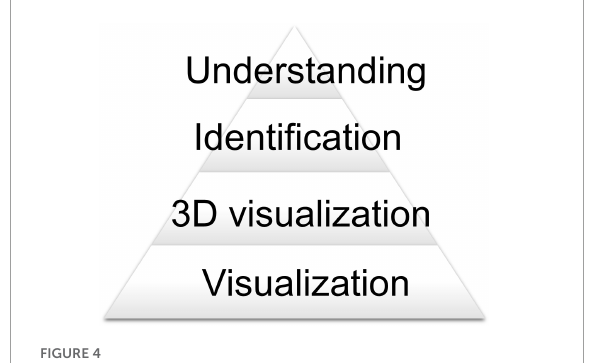
FIGURE5 We represent the interaction between the 3D Vectors, Components, and Angles categories. We present a weighted Venn diagram generated using EulerAPE (Micallef and Rodgers,